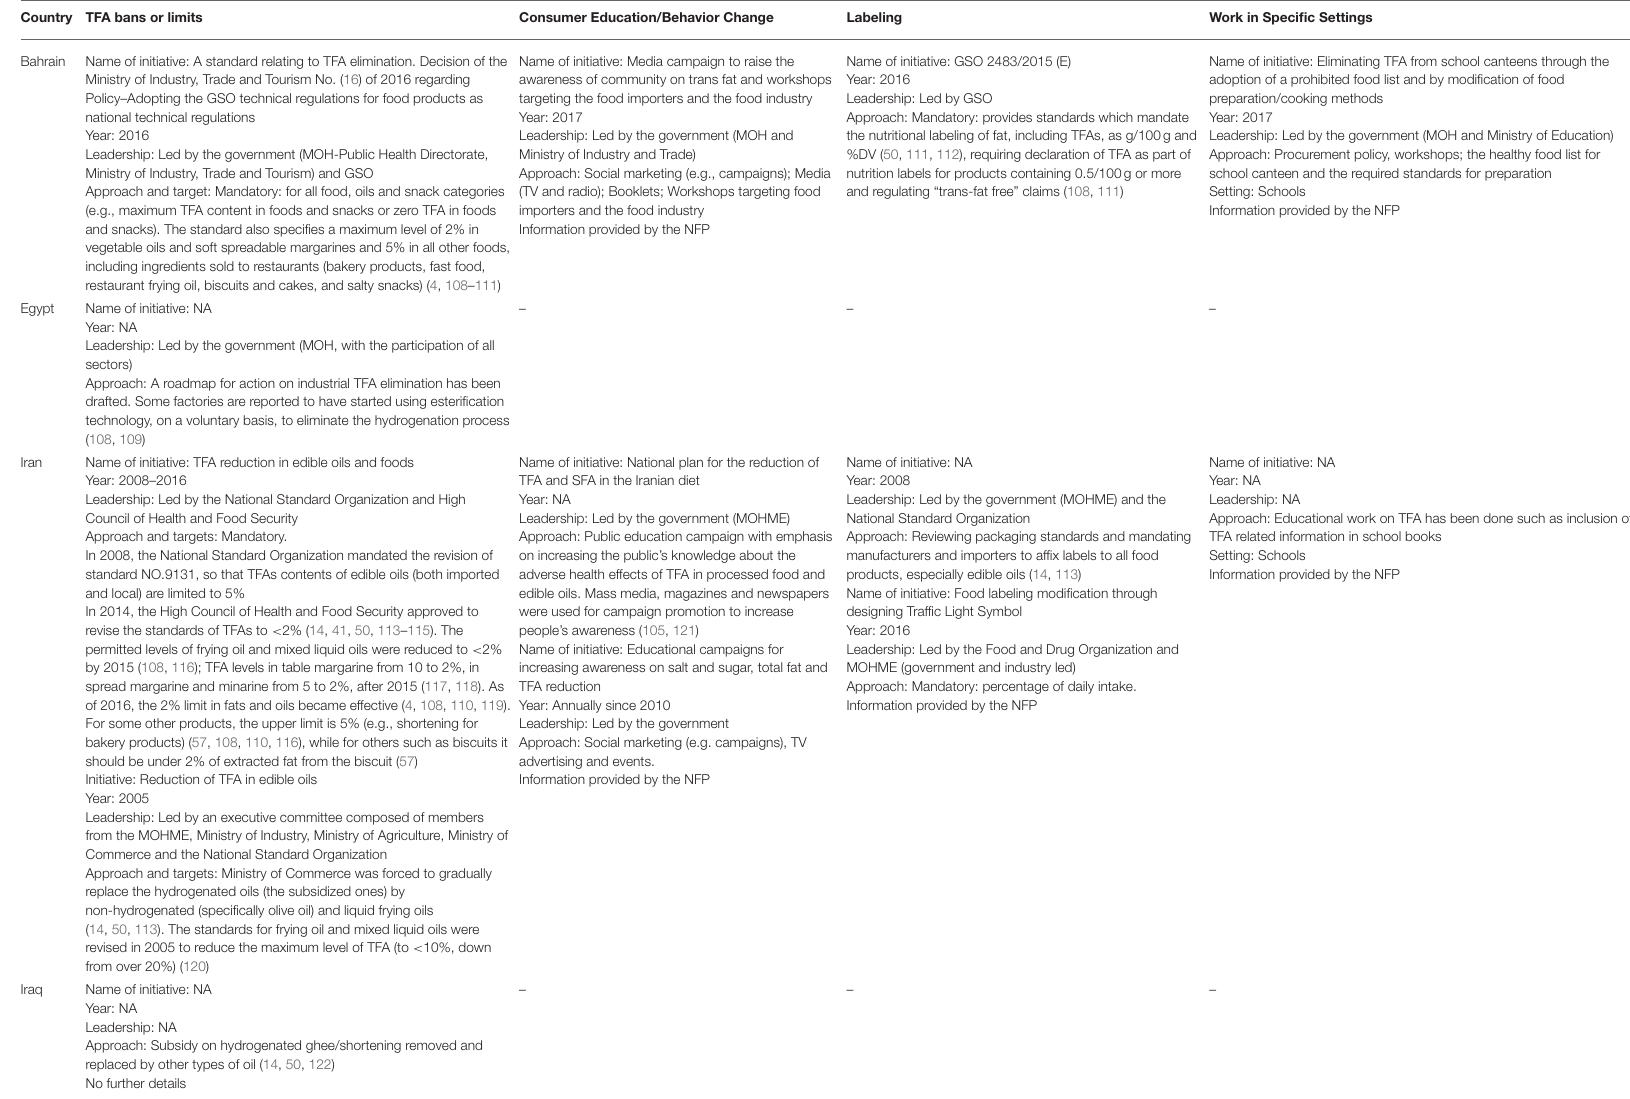
TABLE 1 | TFA reduction implementation strategies in countries of the EMR. Country TFA bans or limits Consumer Education/Behavior Change Labeling Work in Specific